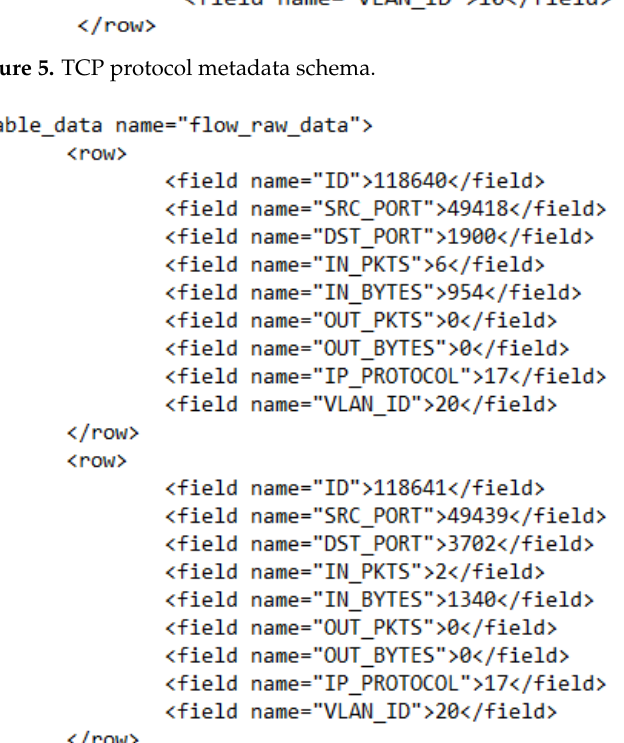
Figure 6. UDP protocol metadata schema.